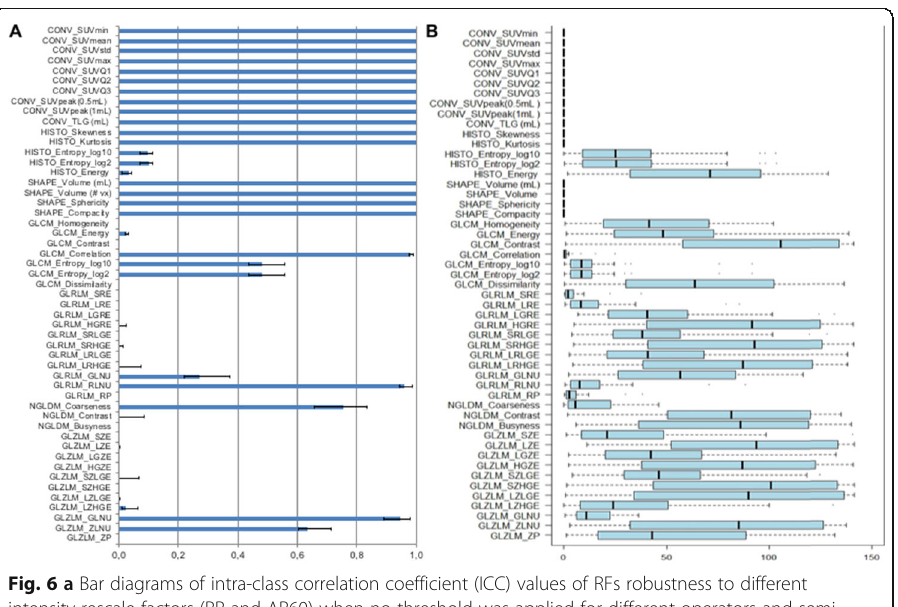
Fig. 6 a Bar diagrams of intra-class correlation coefficient (ICC) values of RFs robustness to different intensity rescale factors (RR and AR60) when no threshold was applied for different operators and semi- automatic algorithm. Bars in blue show the median ICC between different segmentations, applying no threshold. Range error bars (in black) encompass the lowest and highest values for different operators. b Boxplot of COV L for different intensity rescale factors (RR and AR60), applying no threshold, for the first operator (results superposable for the other operators). TLG (total lesion glycolysis) conventional parameter in our study corresponds to the TLSRE (total lesion somatostatin receptor